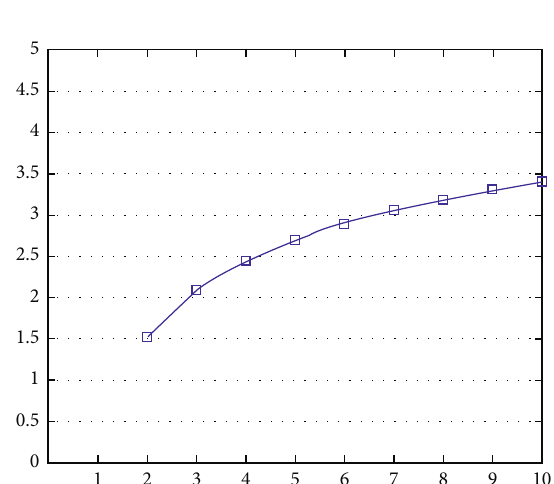
Figure 9: GA entropy of HDN1 ( n ) .